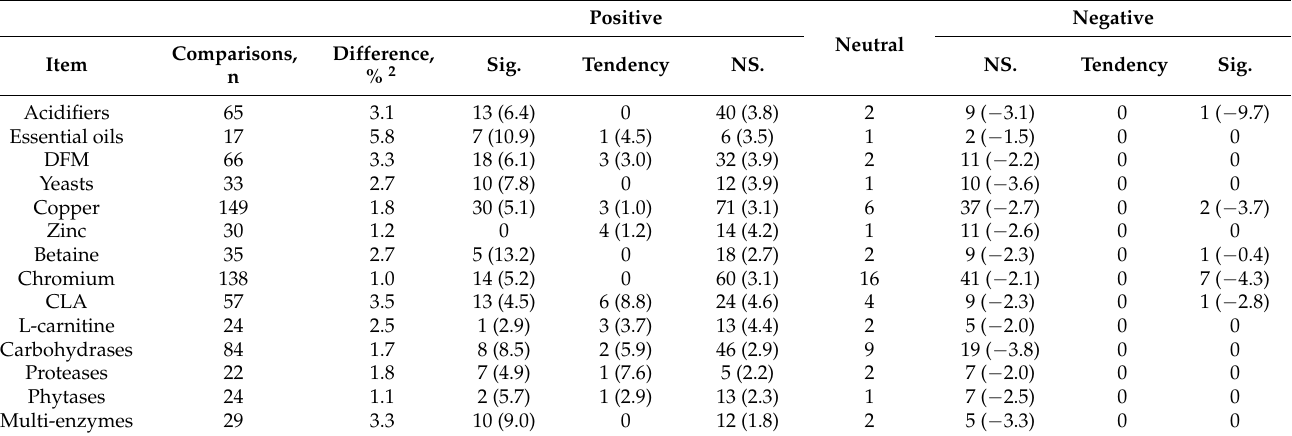
Table 2. Summary of the effects of feed additives on grow–finish pig G:F 1,3 .